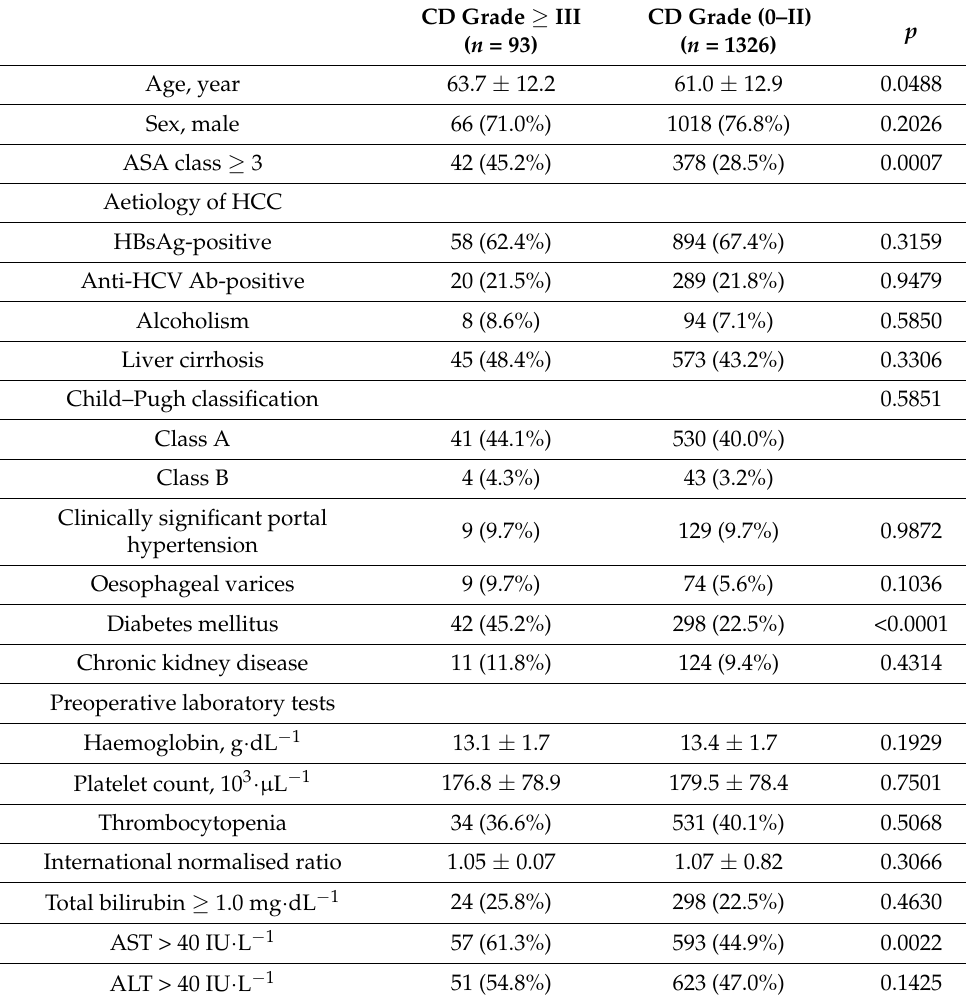
Table 1. Patient demographics, and clinical and pathological